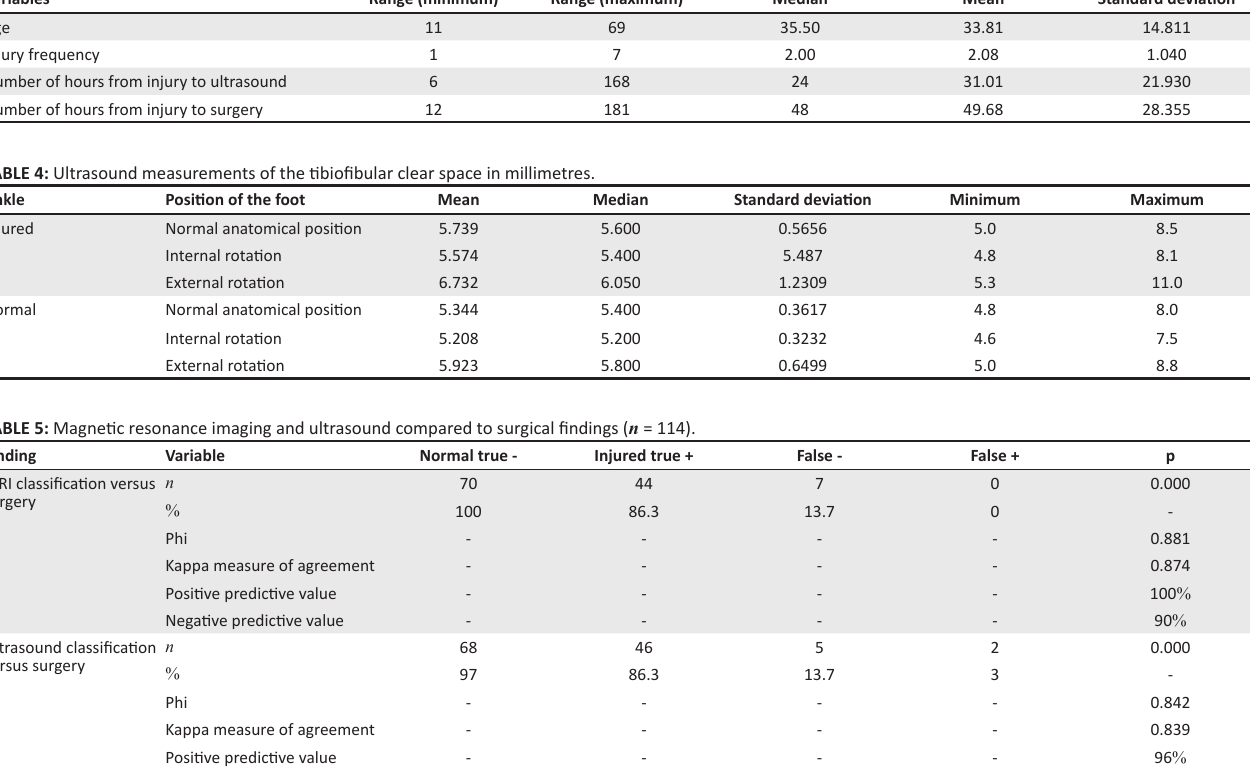
TABLE 3: Characteristics of the study population presented as ranges and means. Variables